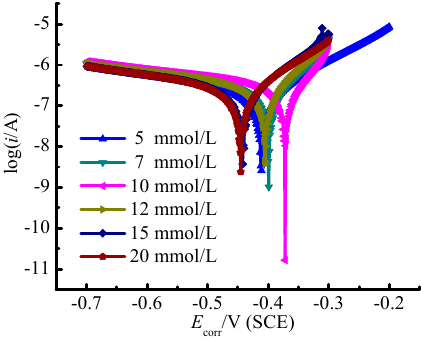
Figure 4. Potentiodynamic polarization curves of TA2 in different SBFs with varied glucose concentrations. Table 5. Electrochemical corrosion parameters determined by Tafel